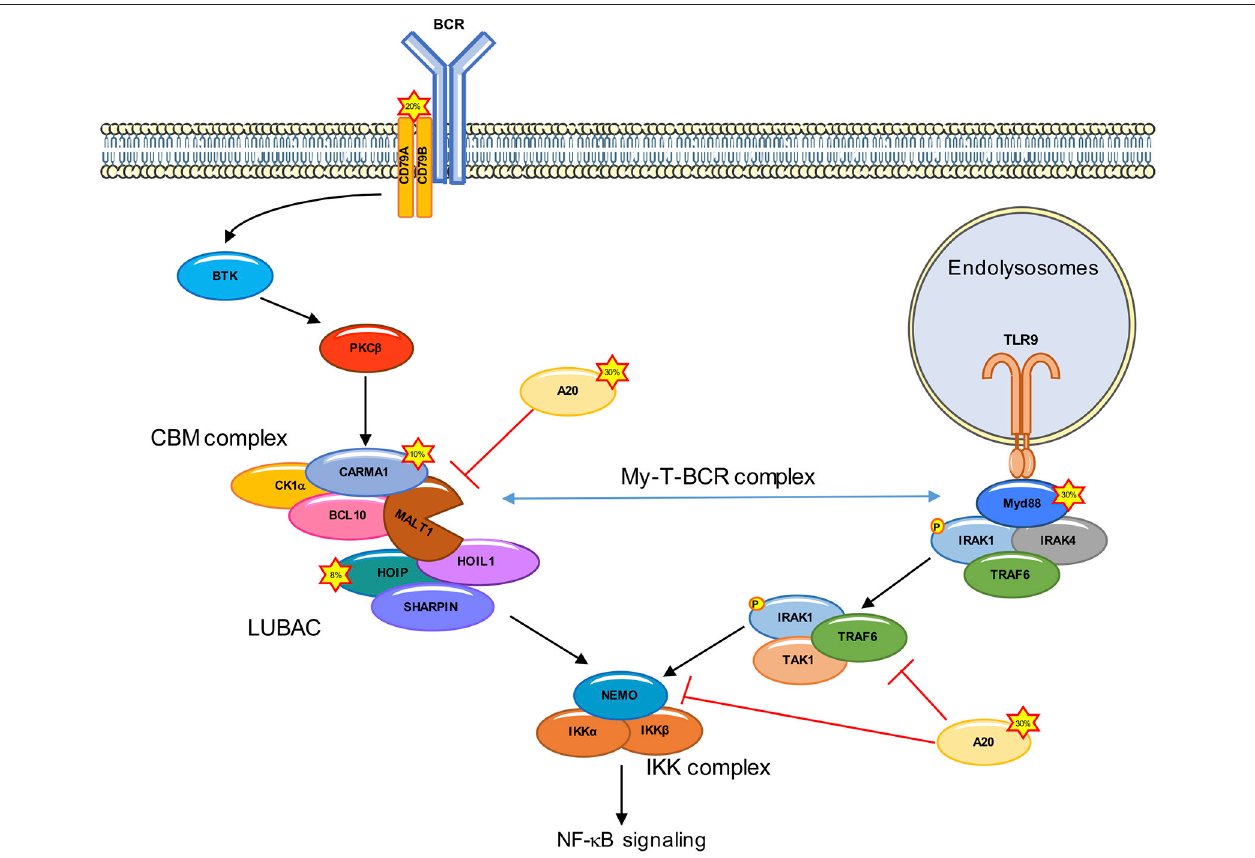
FIGURE 1 | Deregulated NF- κ B signaling in ABC DLBCL. In ABC DLBCL, a combination of genetic lesions leads to an effective hijacking of the BCR signaling cascade, which culminates with the assembly of the CARMA1-BCL10-MALT1 (CBM) complex, and the subsequent IKK/NF- κ B activation. Mutations in ∼ 20% of ABC DLBCL cases occur in the upstream CD79A/B. CARMA1 is mutated in ∼ 10% of ABC DLBCL, leading to a constitutive recruitment of BCL10 and MALT1. Rare polymorphisms in the gene encoding for the LUBAC subunit HOIP ( ∼ 8% of cases) increase the recruitment and activation of the IKK complex. Approximately 30% of ABC DLBCL have A20 loss of function. The Toll-like receptor adaptor MYD88 is also mutated in ∼ 30% of ABC DLBCL. ABC DLBCL carrying both CD79A/B and MYD88 mutations form a signalosome at the endolysomome, consisting of the MYD88, TLR9, and BCR (My-T-BCR complex) which recruits the